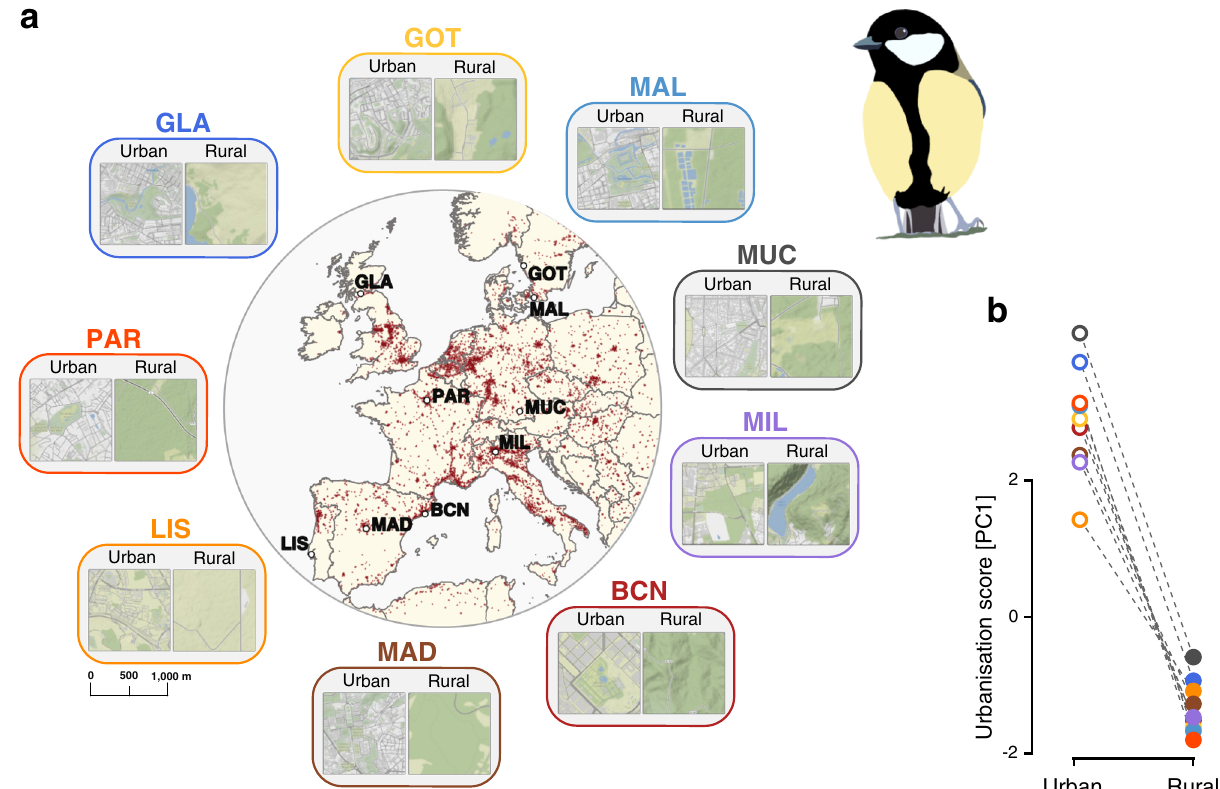
Fig. 1 Study sampling locations and urbanisation intensity. a Centre: map of Europe, showing the targeted cities where the sampling of great tits ( Parus major ) was carried out. Red areas indicate the main dense urban areas. The nine inset zooms fl anking the central map exemplify the landscape and degree of urbanisation for each of the urban – rural sampling locations. Green shading represents canopy or green areas (i.e., vegetation cover) and roads and buildings are represented in grey. See “ Methods ” , Supplementary Fig. 1 and Supplementary Table 1 for more details. Map data sources: Stamen Design under CC BY 3.0 (https://creativecommons.org/licenses/by/3.0/); data licensed by OpenStreetMap Foundation (OSMF) under ODbL (https://opendatacommons.org/licenses/odbl/). Shape fi les: Natural Earth. b Urbanisation scores (principal component, PC urb ) for all nine urban – rural pairs. In both fi gures, the coloured circles represent each city (in b , urban: open circles; rural: closed circles). BCN Barcelona, GLA Glasgow, GOT Gothenburg, LIS Lisbon, MAD Madrid, MAL Malmö, MIL Milan, MUC Munich, PAR Paris. Great tit illustration made by Pablo Salmón. Source data for b is provided as a Source data fi